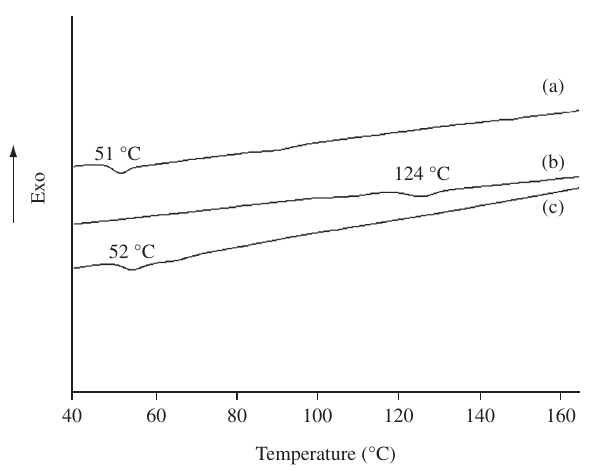
Figure 5. DSC curves of the samples: a) PLGA 75:25 lyophilized; b) lyophi- lized CyA and c) lyophilized mixture PLGA 75:25.